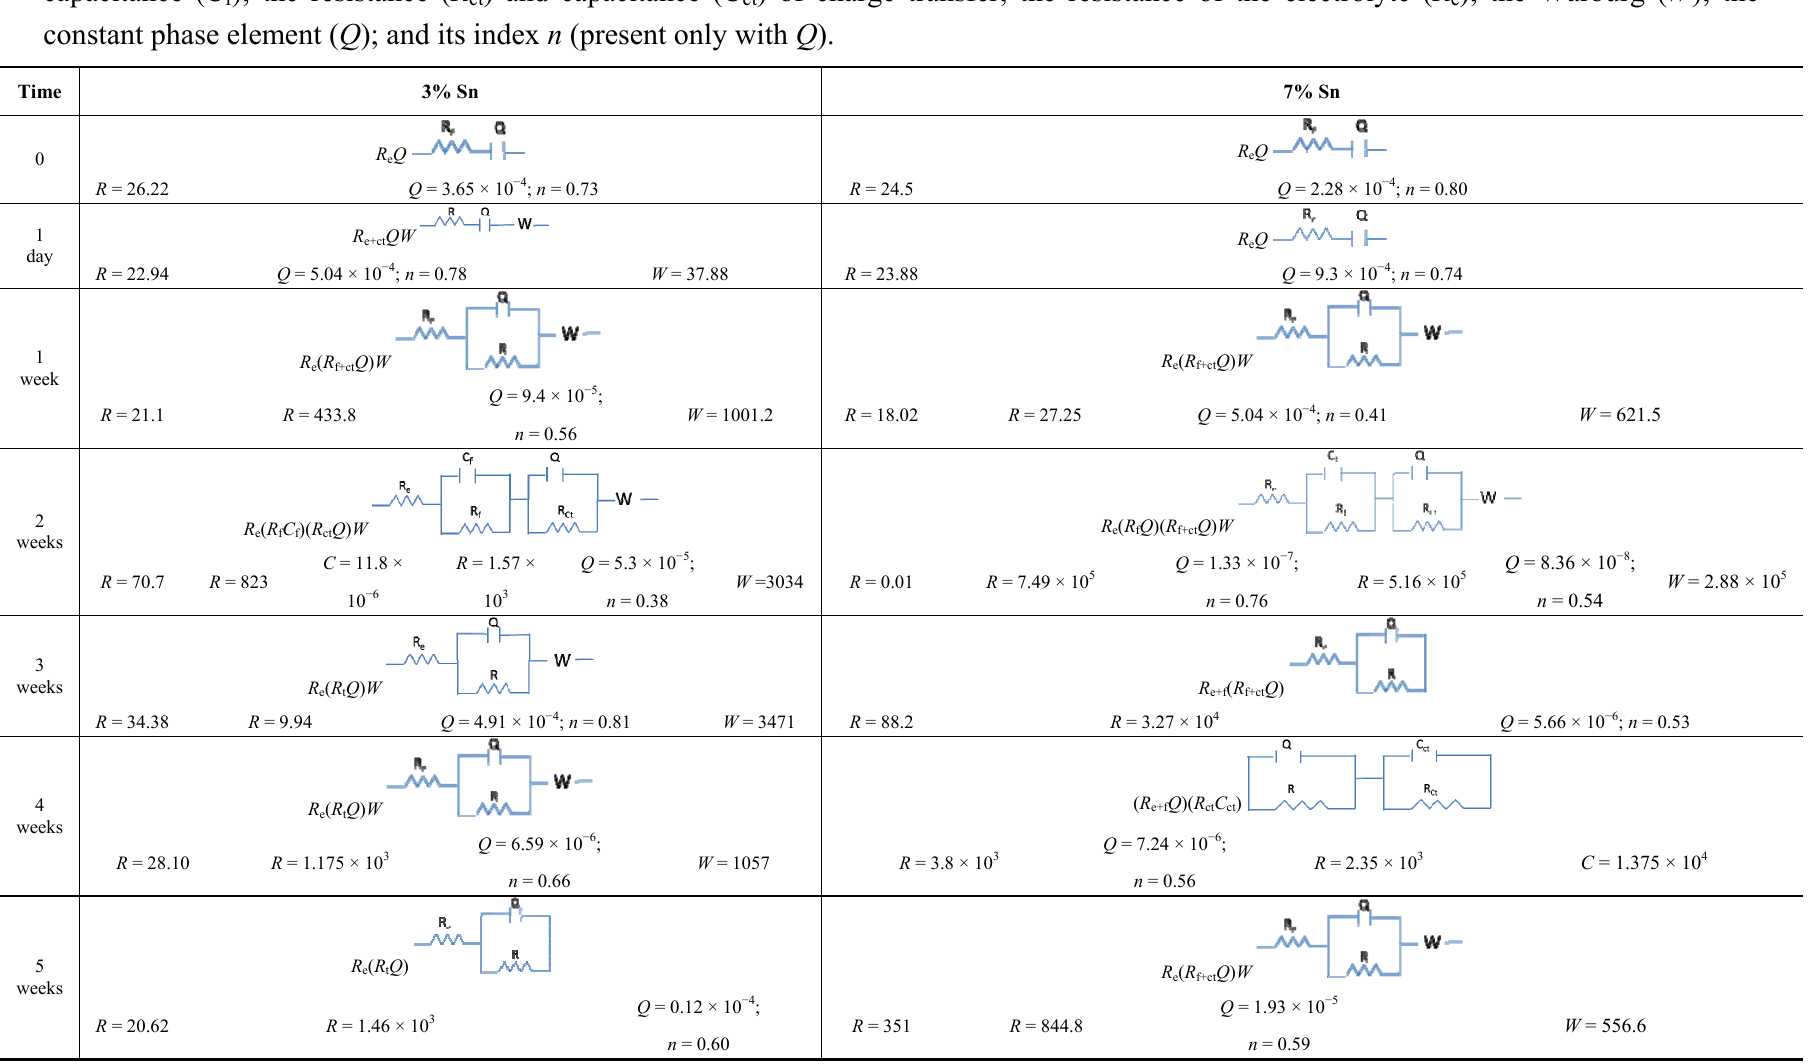
); the film f ); the Warburg ( W ); the e